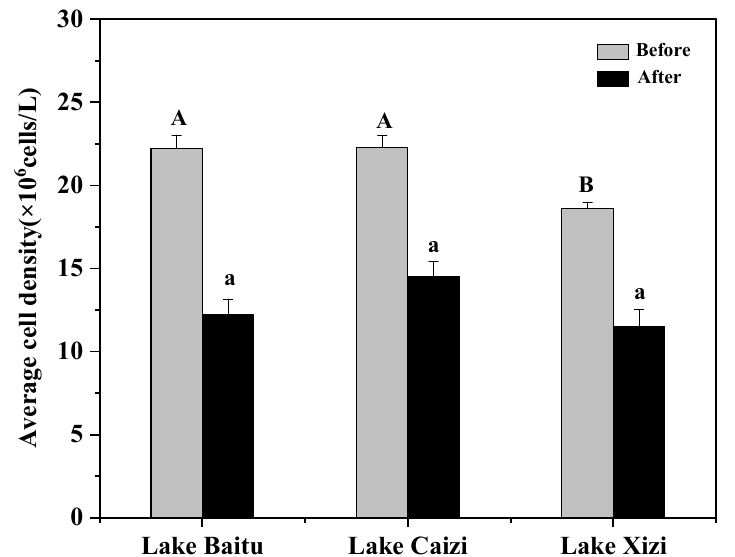
Figure 5. Spatial variation of phytoplankton cell density before and after the aquatic vegetation res- toration. Upper case letters indicate significant differences between lakes before restoration, lower case letters indicate significant differences between lakes after restoration. The comparison between upper- and lower-case letters for each lake indicated significant differences before and after resto- ration. The same letter indicated a non-significant difference ( p > 0.05), different letters indicated a significant difference ( p < 0.05).